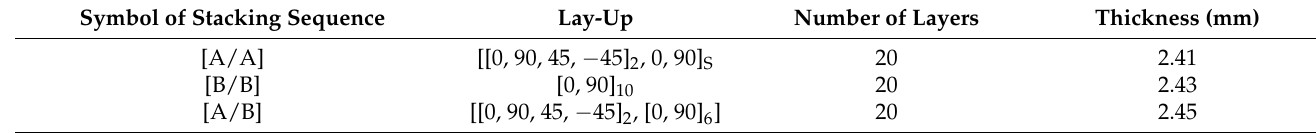
Table 2. The specifications of the stacking